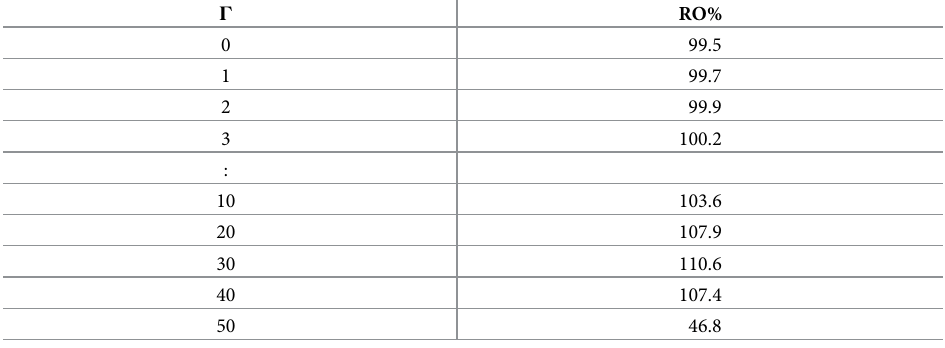
Table 14. Variation of the objective function when demand deviation value changes from